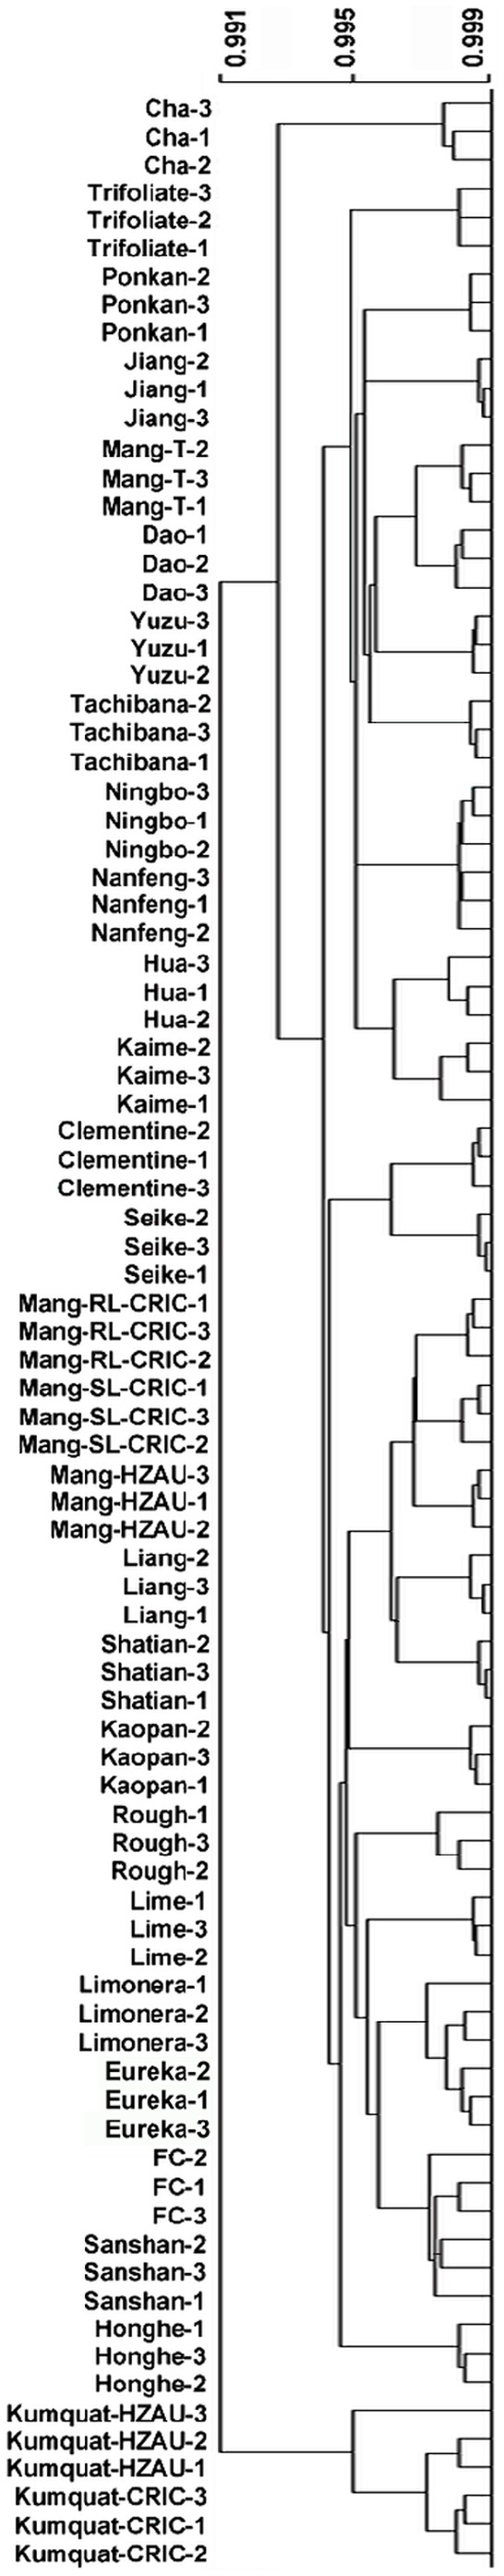
Hierarchical cluster analysis (HCA) results of leaf volatiles.